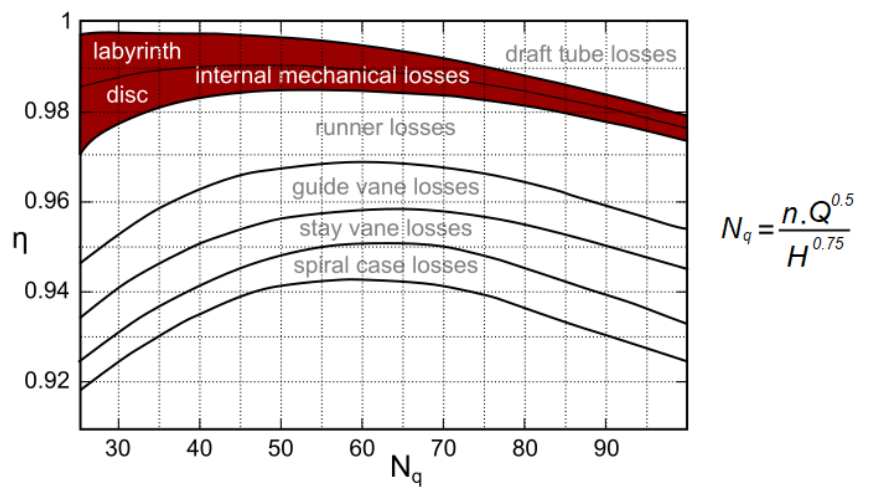
Figure 11. Losses related to flow in sidewall spaces of Francis turbine as function of specific speed